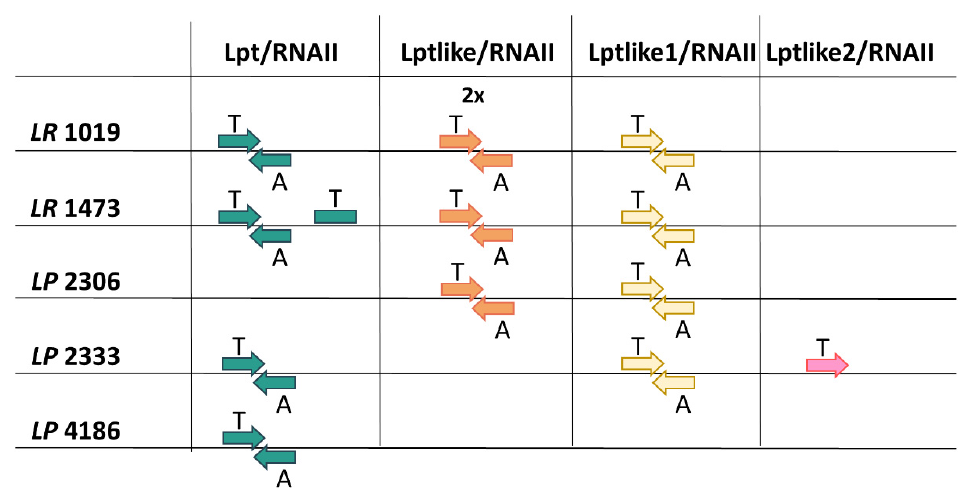
Figure 4. Distribution and organization of the identified type I TA systems. Toxins and antitoxins are indicated by T and A, respectively. Abbreviations in strain names are as follows: LP: L. paracasei , LR: L. rhamnosus . The arrows indicate transcription direction of T and A, their absence highlights the promoter Scheme 15. Lactocaseibacillus strains used as references for genome analysis (Table S1). By using the tBlastn program, one Lpt and two Lptlike2 were identified, while no Lptlike and Lptlike1 were found. The identified Lpt sequence is located on the plasmid pLBPC-2 of L. paracasei JCM 8130 and it was previously described in Folli et al. [17]. Lptlike2 sequences were found in L. paracasei JCM 8130 and in L. paracasei ATCC334 and the alignment of the nucleotide sequences encompassing their coding regions is shown in Figure S3 in comparison with Lptlike2 of L.paracasei 2333. Interestingly, it was not possible to predict convergently transcripted RNA molecules able to act as antitoxins in any of these sequences.